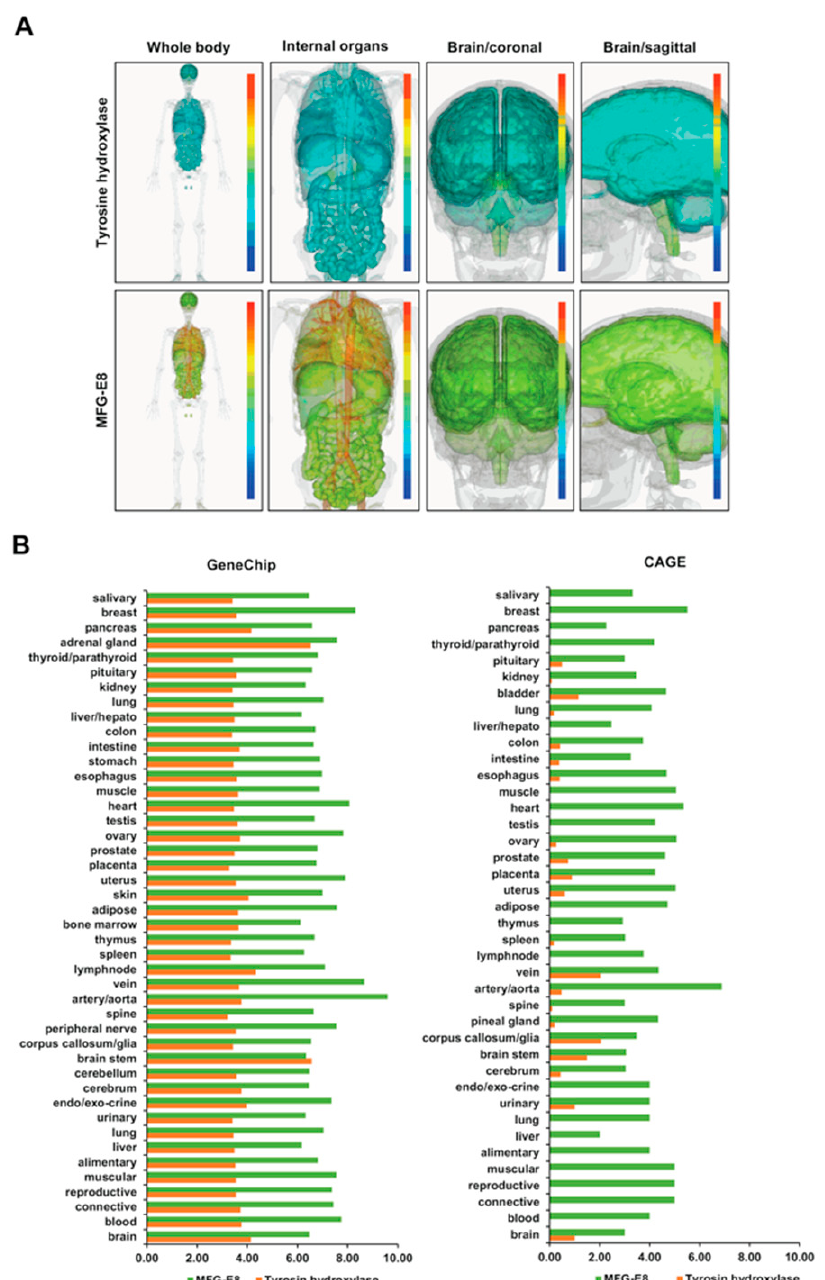
Figure 1. The distribution of the TH and MFG-E8 DNA and mRNA expression by the systemic organs of the whole body. The RefEx-based quantification of the DNA expression of the TH ( A , upper panel) and MFG-E8 ( A , lower panel) genes. From the left, models of human transmission in the whole body, internal organs, brain (coronal), brain (sagittal). Red and blue denote high and low expression levels, respectively. The DNA expression of MFG-E8 and TH in 44 major groups of normal tissues ( B , left panel). The mRNA expression of MFG-E8 and TH was identified in the 44 major groups of normal tissues ( B , right